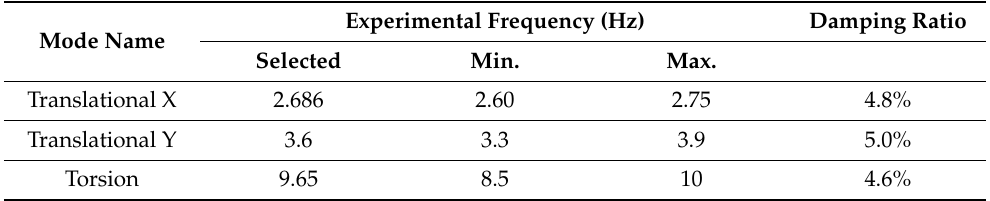
Table 4. Natural frequencies of the extracted mode shapes with the corresponding damping ratio.